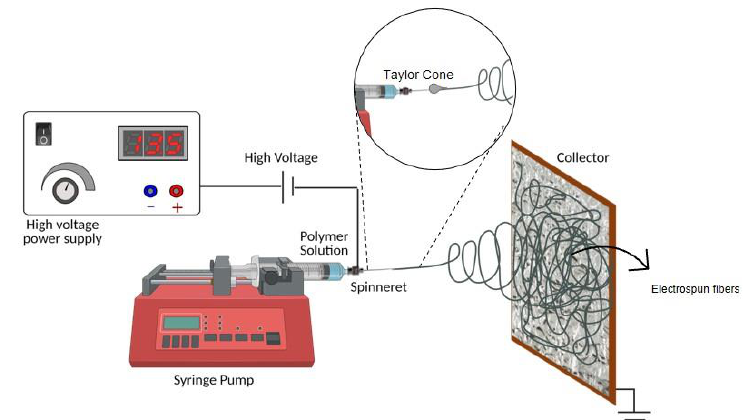
Figure 2. Schematic representation of electrospinning apparatus.